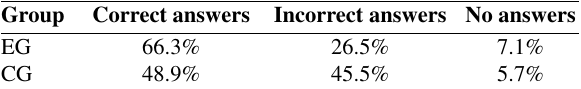
Table 4. Formation of propene (reactant 2-chloropropane), percen- tages of correct and incorrect answers. Group